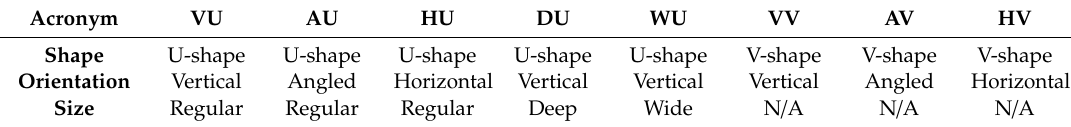
Figure 1. Artificial surface used in this study. Table 1. Characteristics of artificial channels on the artificial surface.